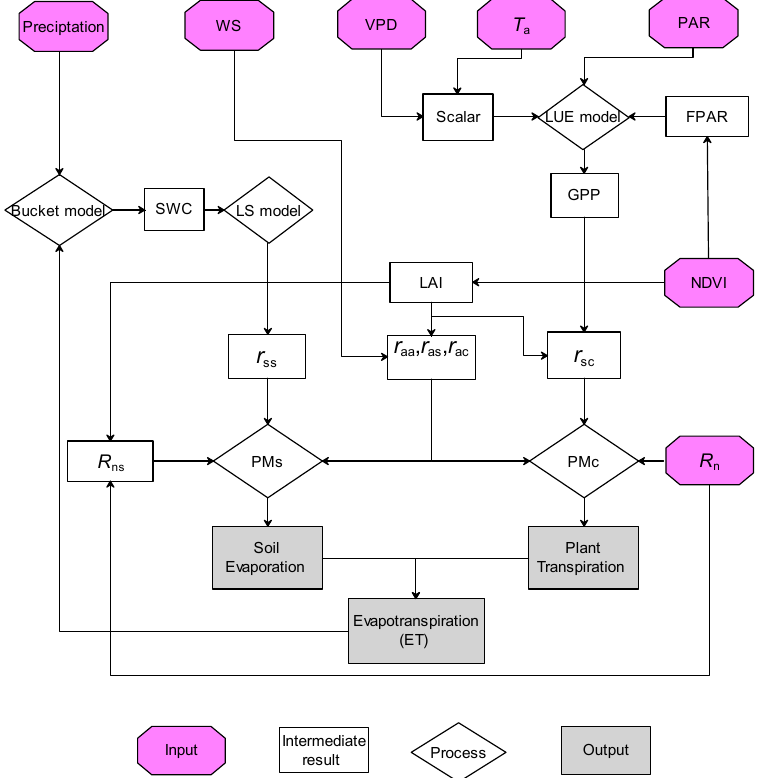
Figure 1. Flowchart of evapotranspiration (ET) estimation with the SWH model. The meanings of the acronyms in this figure are available in Appendix B.